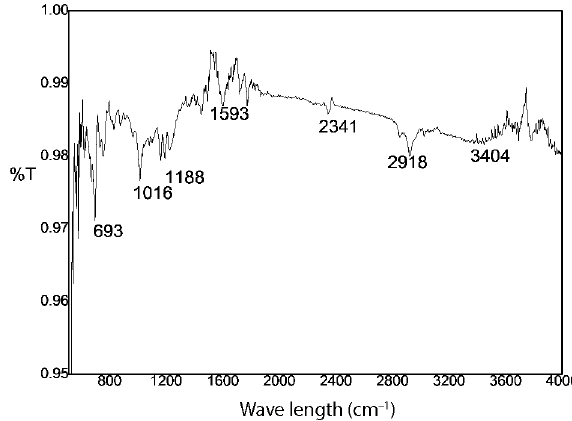
Figure 2. Fourier Transform Infrared Spectroscopy analysis spectra of keyboard plastic waste sample